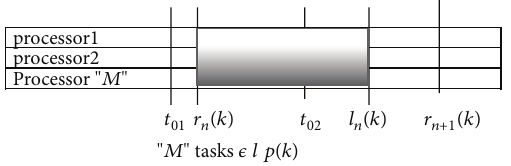
Figure 6: “ M ” tasks ∈ 𝑙𝑝(𝑘) starting to execute at 𝑡 ∈ [𝑡 01 , 𝑟 𝑛 (𝑘)] .